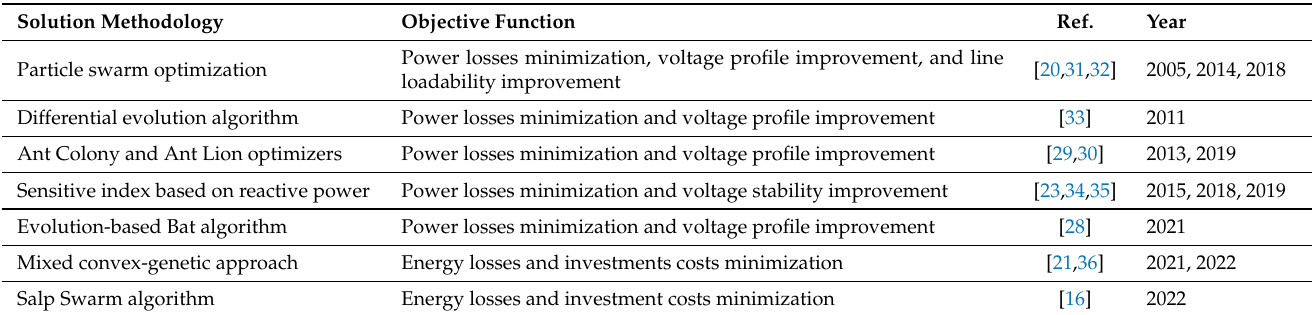
Table 1. Recent literature reports associated with the problem regarding the optimal siting and sizing of D-STATCOMs in distribution